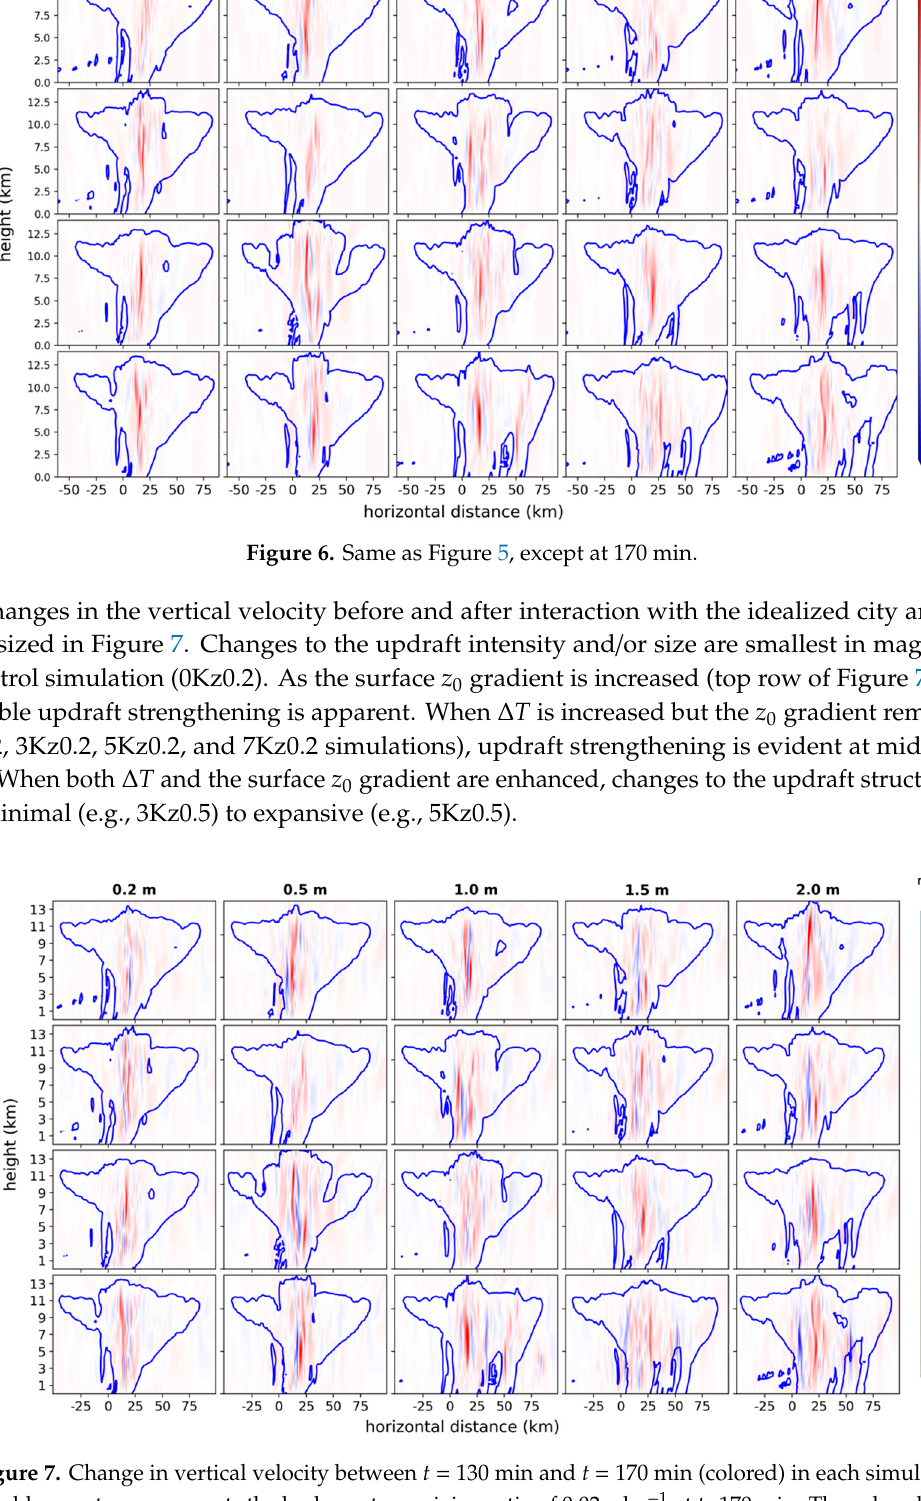
Figure 5. Vertical velocity (colored) at t = 130 min in each simulation. The blue contour represents a hydrometeor mixing ratio of 0.02 g kg − 1 .